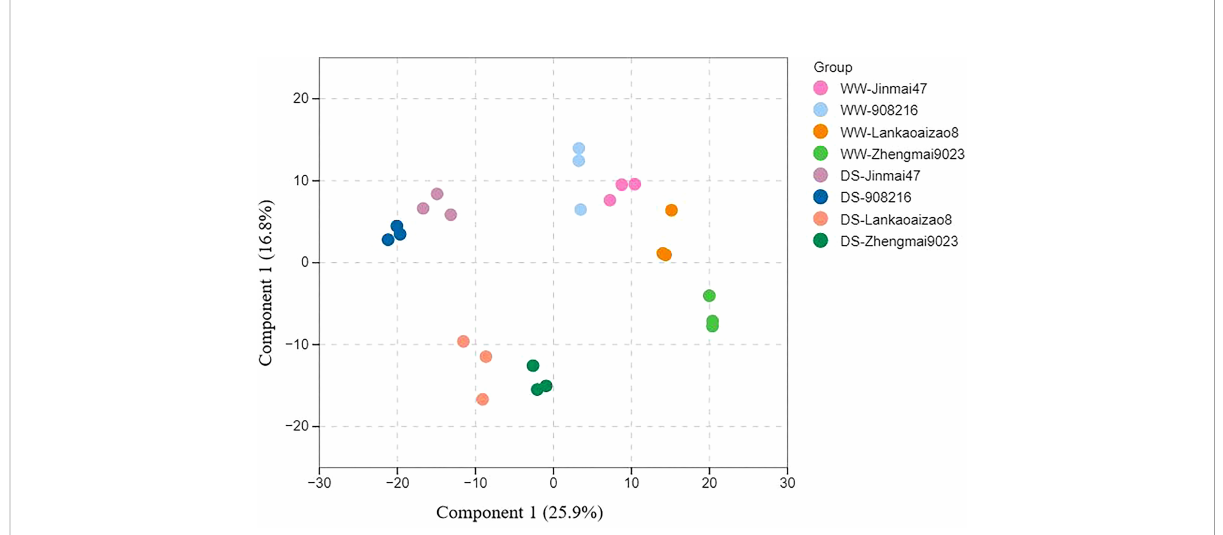
FIGURE 4 Metabolome analysis of the four wheat genotypes leaves under well-watered condition (WS) and water stress condition (WW). The data is analyzed by orthogonal partial least squares-discriminant analysis. Component 1: the fi rst principal component, Component 2: the second principal component. Three biological replicates (n=3) were set up for each